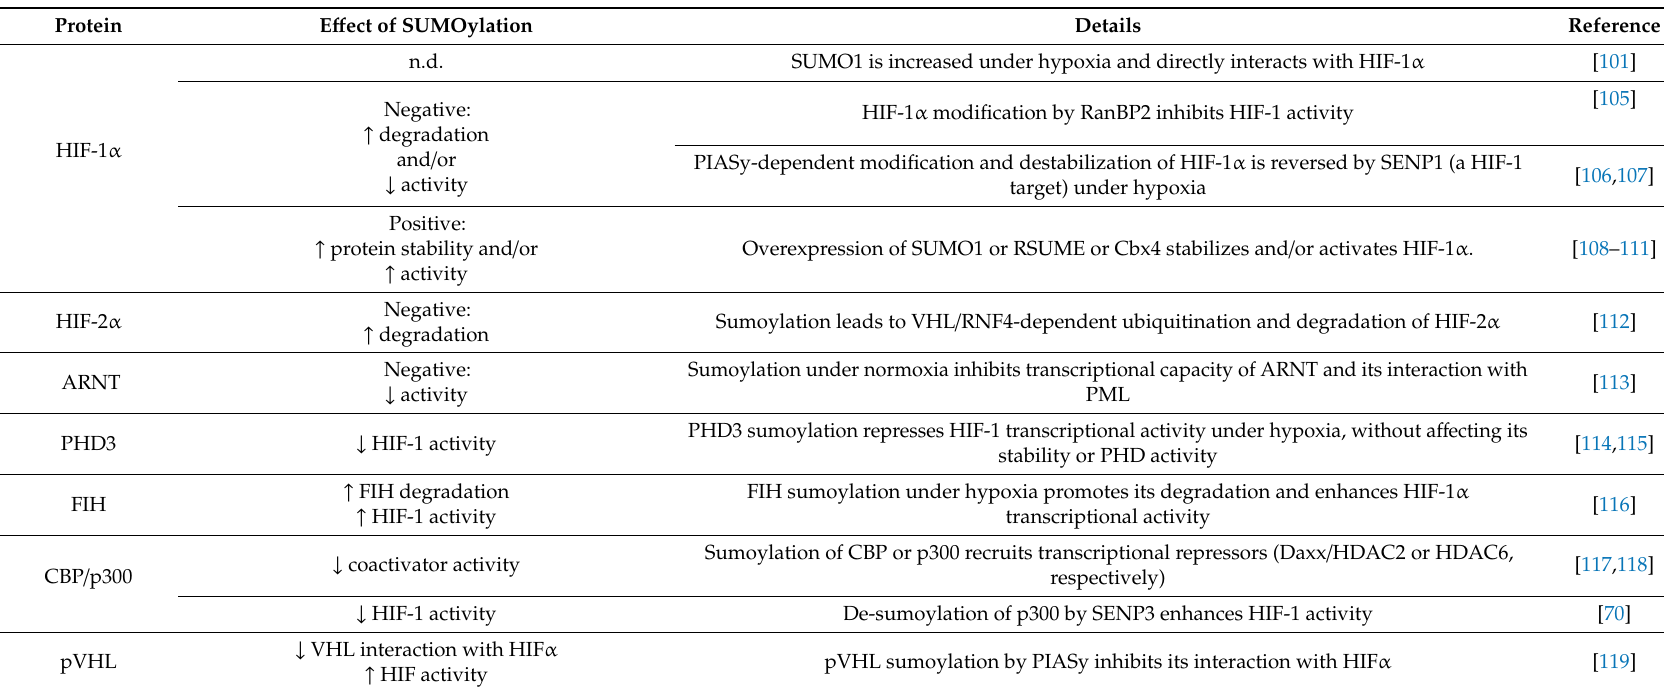
Table 1. The e ff ect of sumoylation on key elements of the hypoxic